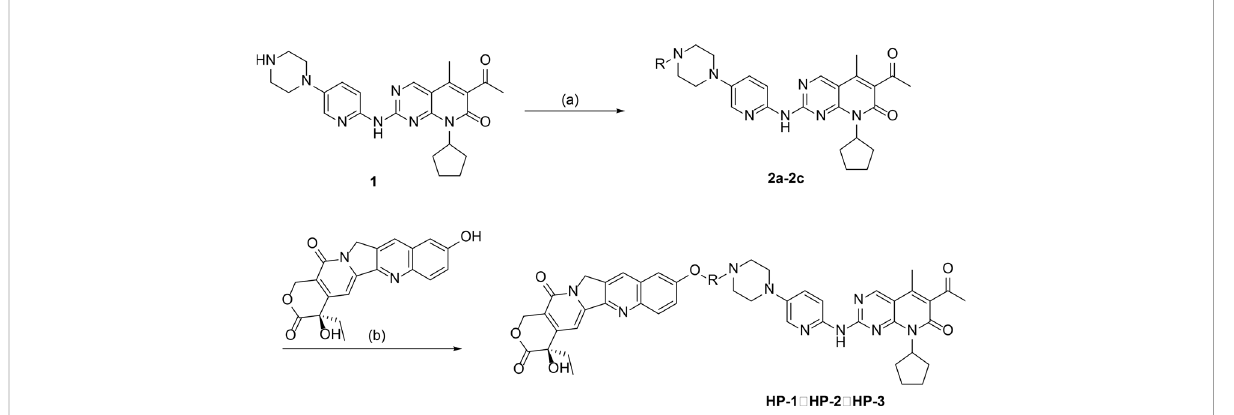
FIGURE 1 The synthetic routes of palbociclib 10-HCPT ester derivatives ( HP-1 , HP-2 , and HP-3 ) [reagents and conditions: (A) DMF, anhydride, 70°C, 24 h; (B) EDCI, DMAP, CH 2 Cl 2 , 4 h].